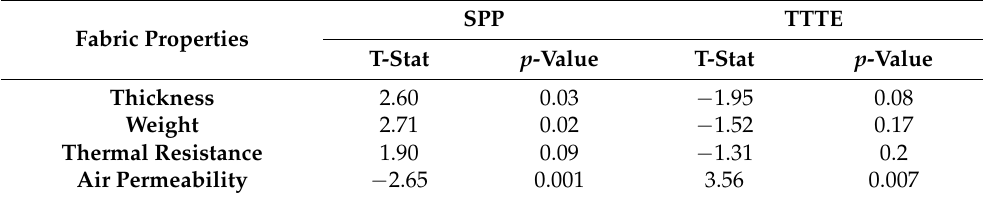
Table 5. Results of t -test.